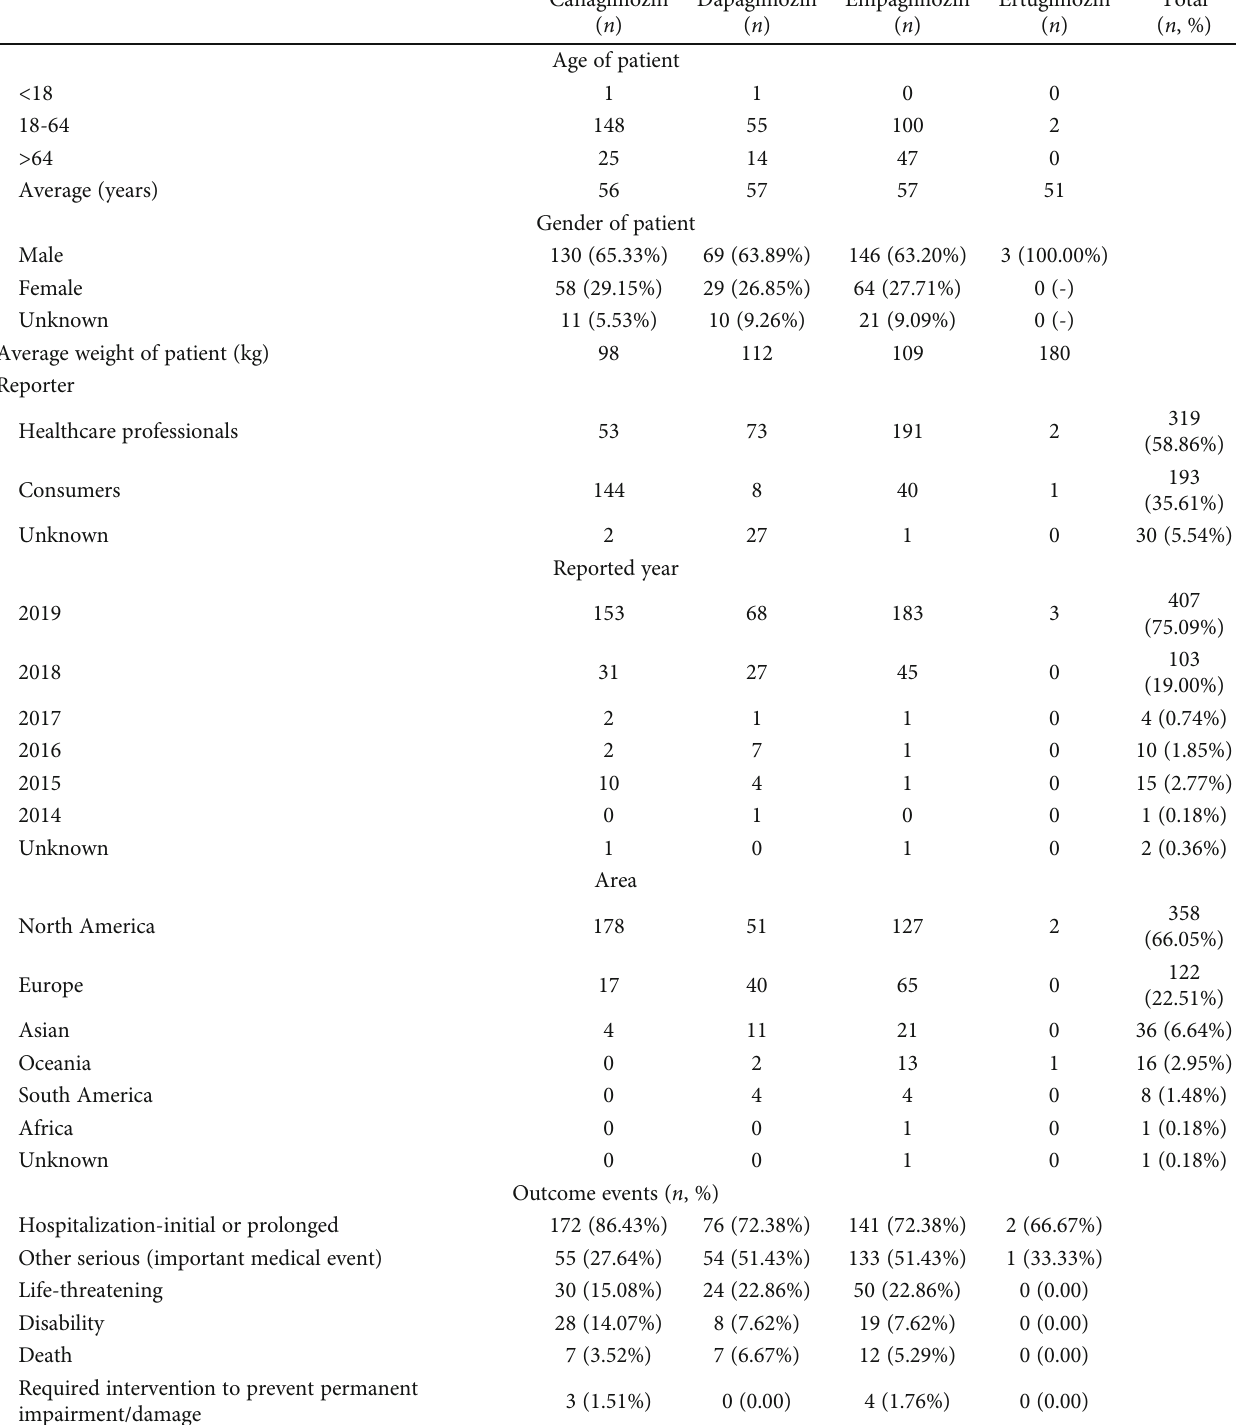
Table 3: Detailed information on FG